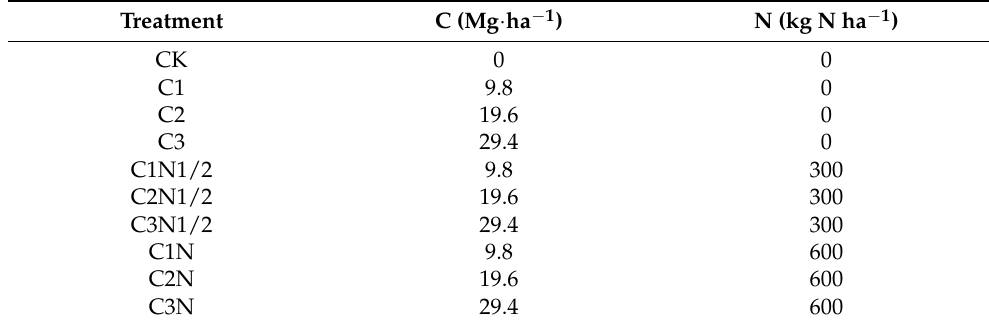
Table 1. Application rates of biochar and nitrogen fertilizer in different treatments.